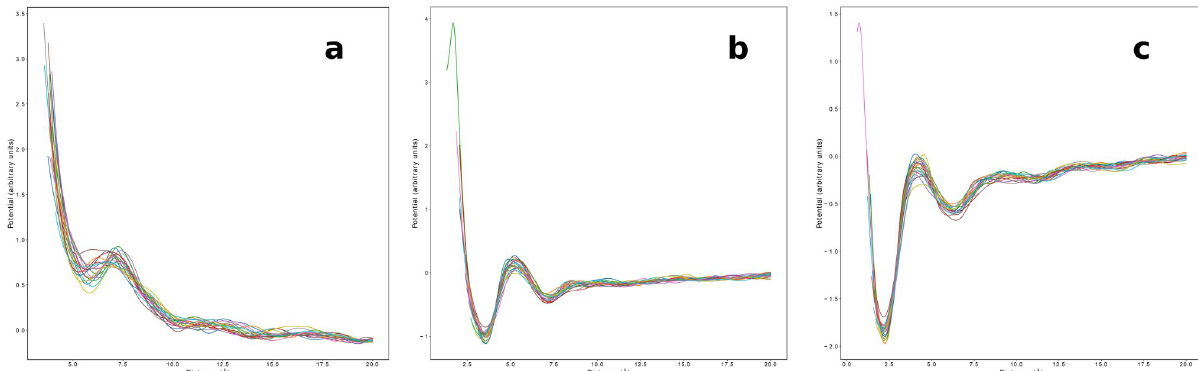
Fig 4. Empirical knowledge-based potentials for different coarse-graining levels. Effective potential V m ( R ) estimated for each 70 � m � 90 in the Flory regime using Eq (9). Remarkably, the curves obtained with this procedure do not depend on the fragment length and can therefore be interpreted as an effective potential between the terminal fragment residues. In this case, where all fragments are considered regardless of the type of amino acids at their ends, the potential can be interpreted as a generic sequence independent interaction between all residues. ( a ) CA representation. ( b ) HV representation. ( c ) HH representation. Figure drawn with python package matplotlib, version 3.4.1. URL https://pypi.org/project/matplotlib/.